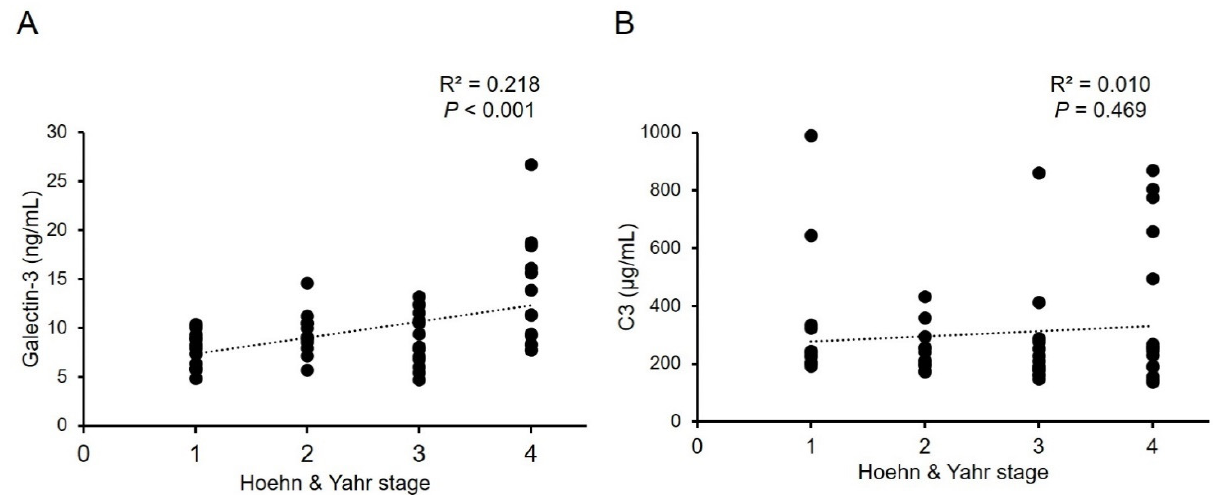
Figure 2. Correlations between serum levels of ( A ) galectin-3, or ( B ) C3, and Hoehn and Yahr stages in patients with Parkinson’s disease. R 2 : Pearson’s correlation coefficient. ( n = 56).